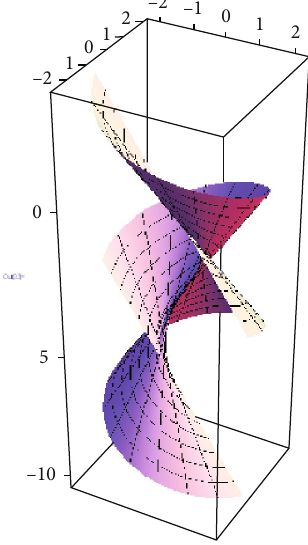
Figure 5: ð X Þ with h = 0 : 5 and ψ ∗ = 1